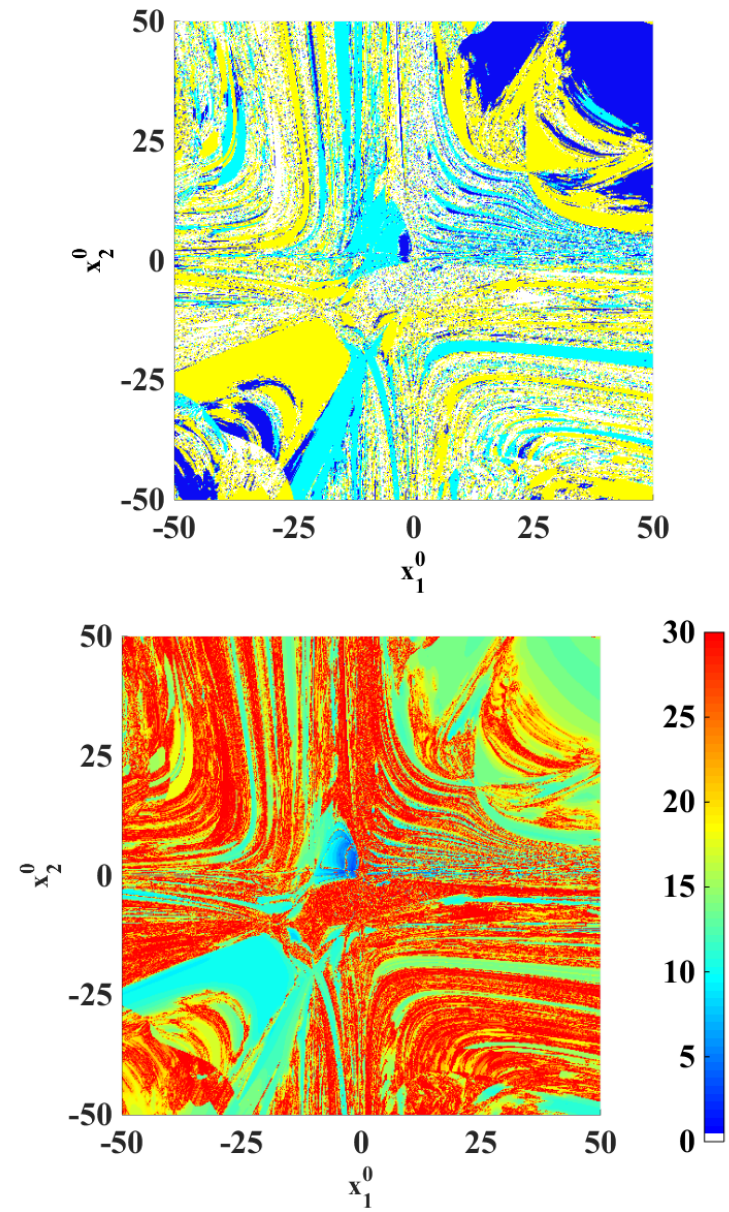
Figure 4. Basins of attraction ( upper ) and number of iterations ( lower ) for the fourth-order system when the factored method with m = 10 is